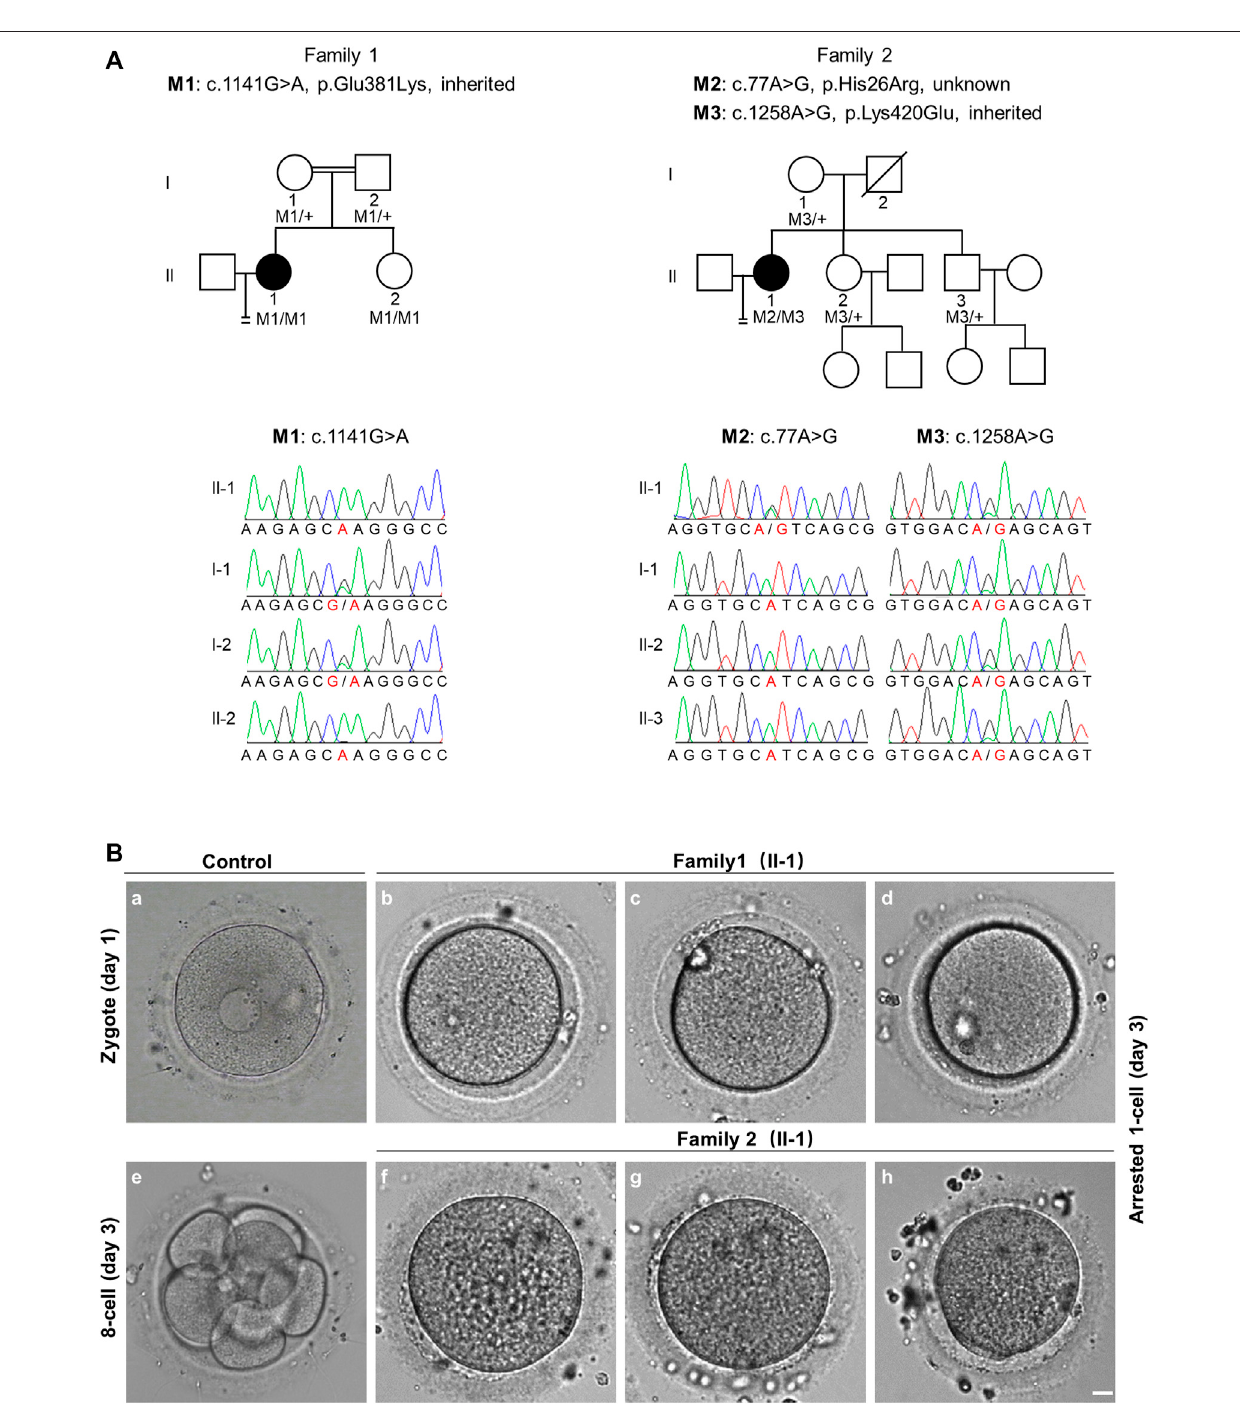
FIGURE 1 | Pedigree-based identi fi cation of TRIP13 variants and the zygotic cleavage failure (ZCF) phenotype. (A) Genetic analysis of two patients from different families affected by ZCF. Black circles indicate the affected individuals. Sanger sequencing con fi rmation is shown below the pedigrees. (B) Morphology of a control embryo and arrested embryos from both patients on day 3. All six arrested 1-cell embryos were from two-pronucleus fertilized oocytes. Scale bar = 10 μ m.